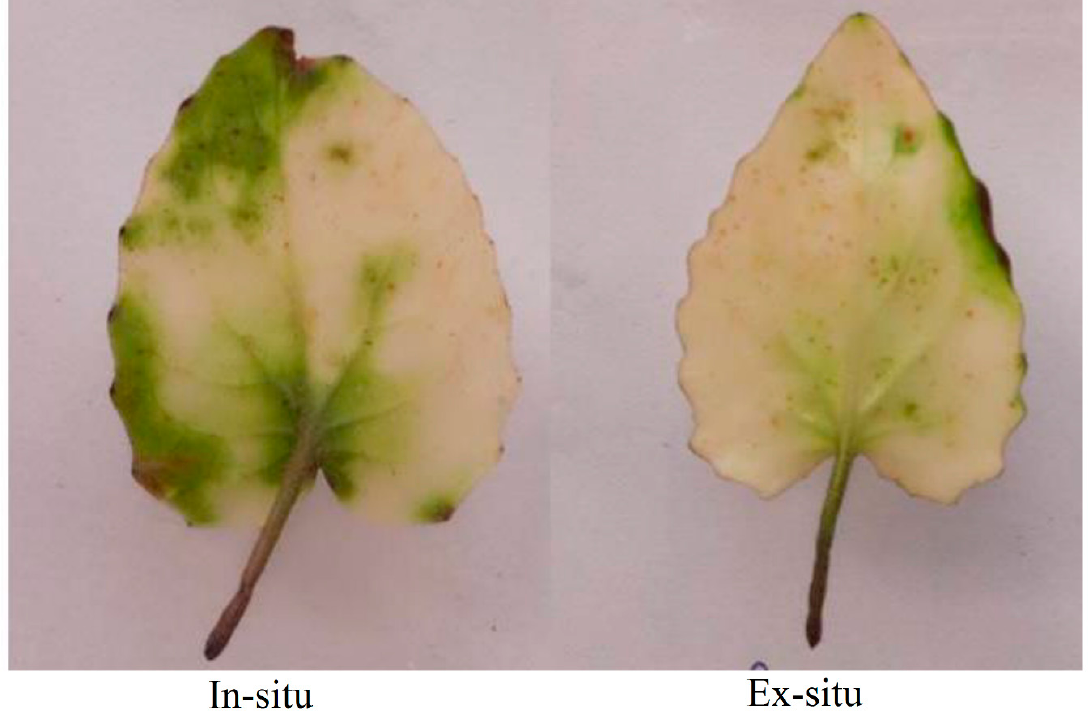
Figure 2. Accumulation of H 2 O 2 in in-situ and ex-situ grown plants of Valeriana wallichii .